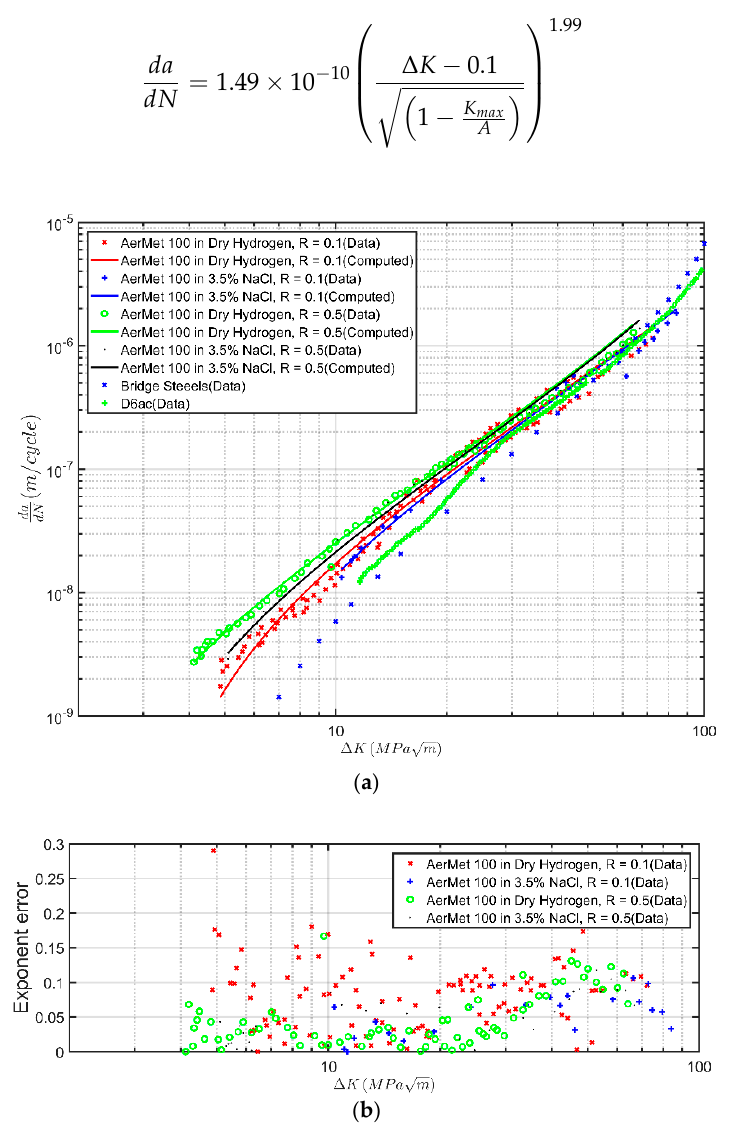
Figure 10. ( a ) Measured and computed growth in conventionally manufactured AerMet 100 and comparison with crack growth curves for D6ac steel and bridge steels; ( b ) Exponent error of the fitted curves as computed using Equation (5).